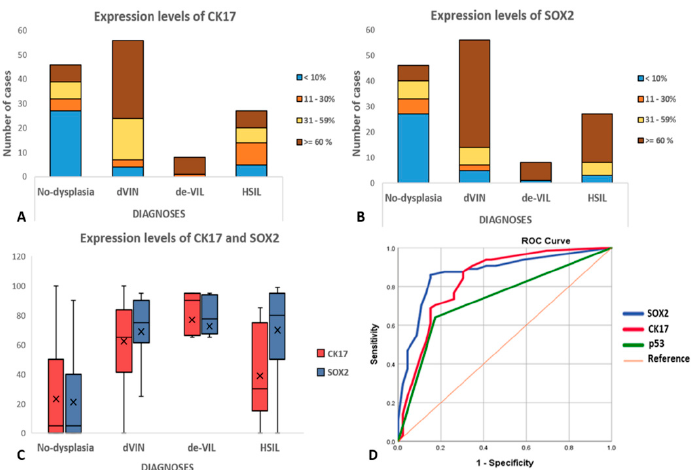
Figure 5. ( A ) Bar-charts depicting the levels of CK17-expression and ( B ) SOX2-expression. For each diagnostic category, color-coding represents the percentage of cells showing cytoplasmic CK17-expression, or nuclear SOX2-expression stratified as <10%, 11–30%, 31–59%, and ≥ 60%; ( C ) Boxplots depicting the distribution of CK17 and SOX2 expression for each diagnostic category; horizontal lines in the boxes represent the medians, the cross-marks represent the mean, and the whiskers represent the 5th and 95th percentiles; ( D ) Receiver operating characteristics (ROC) curves for SOX2 (blue line), CK17 (red line), and p53 (green line) immunohistochemistry for the diagnosis of dVIN. Area under the curve (AUC) for SOX2 = 0.87, CK17 = 0.82, and p53 = 0.78.